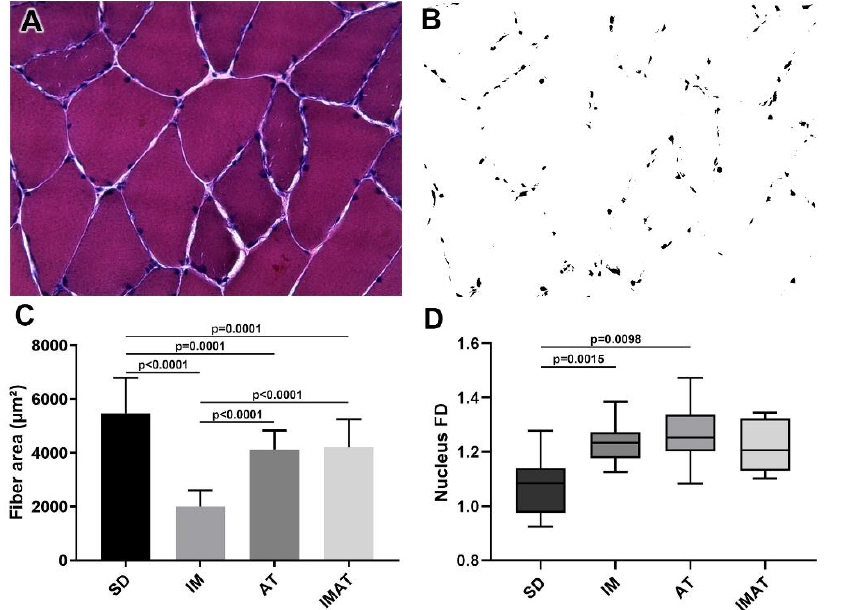
Figure 1. Analysis of muscle fibers of the belly of gastrocnemius muscle of Wistar rats. ( A ) Light microscopy of belly muscle in hematoxylin-eosin staining (HE), magnification: 400×. ( B ) Binarized image of HE staining with nucleus highlight for fractal dimension (FD) analysis. ( C ) Mean ± standard deviation of muscle fibers area (µm²) of sedentary (SD), immobilization (IM), aquatic training (AT), and immobilization/aquatic training (IMAT); SD ≠ AT ( p = 0.0001), SD ≠ IM ( p < 0.0001), SD ≠ IMAT ( p = 0.0001), AT (cid:54) = IM ( p < 0.0001), and IM (cid:54) = IMAT ( p < 0.0001). ( D ) Box plot of nucleus FD analysis of groups; SD (cid:54) = AT ( p = 0.0015) and SD (cid:54) = IM ( p =